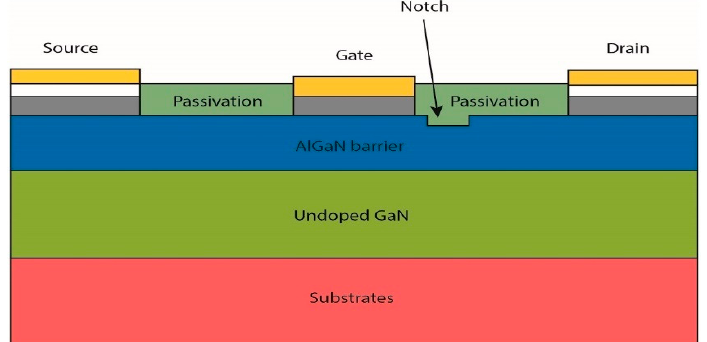
Figure 19. Illustration of AlGaN/GaN/HEMT structure with a notch formed between the passivation layer and AlGaN barrier.